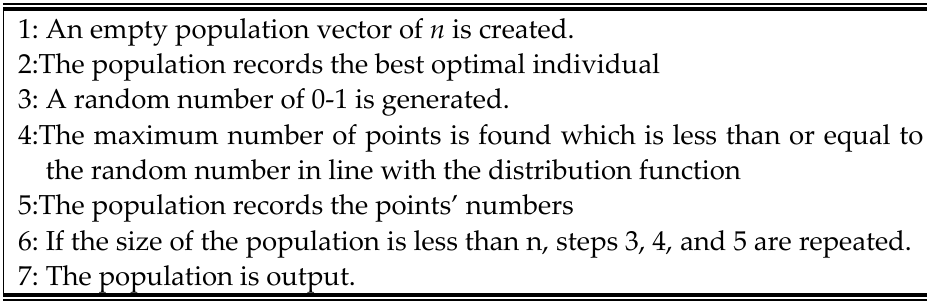
Figure 18. The selection operation process.